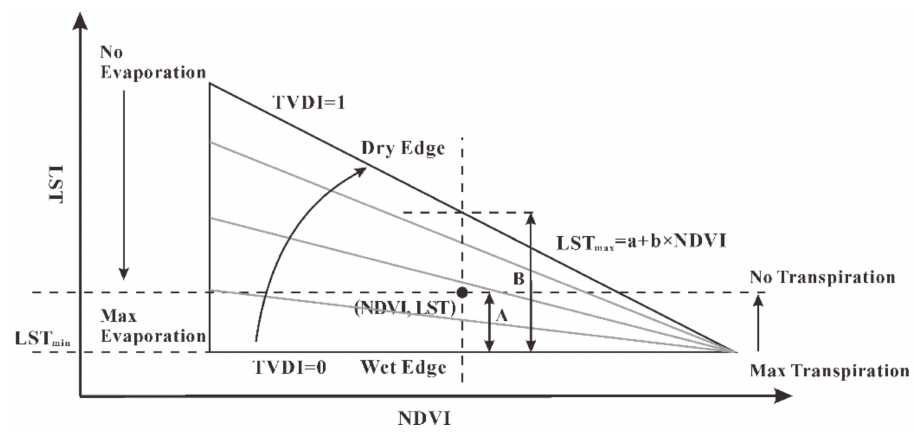
Figure 2. Definition of the temperature vegetation dryness index (TVDI)